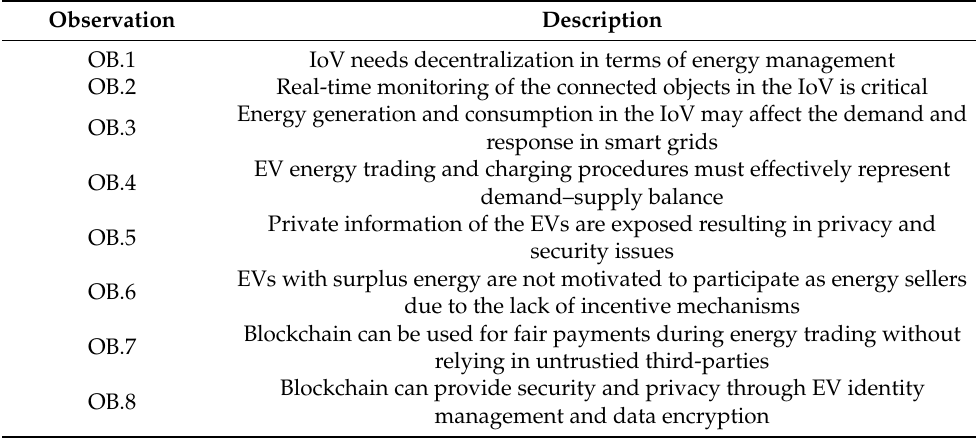
Table 5. Observations derived from the systematic literature review